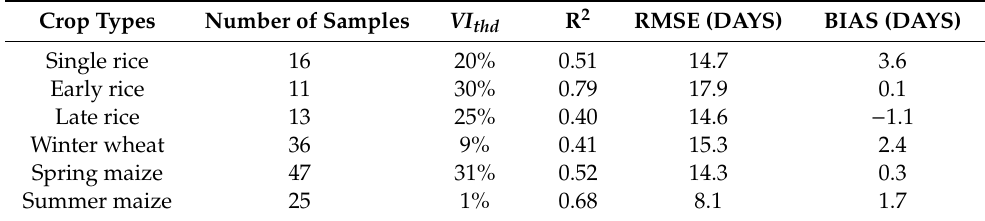
Table 2. Crop-specific optimal thresholds for retrieving the start of the season (SOS) based on Normalized Di ff erence Vegetation Index (NDVI).